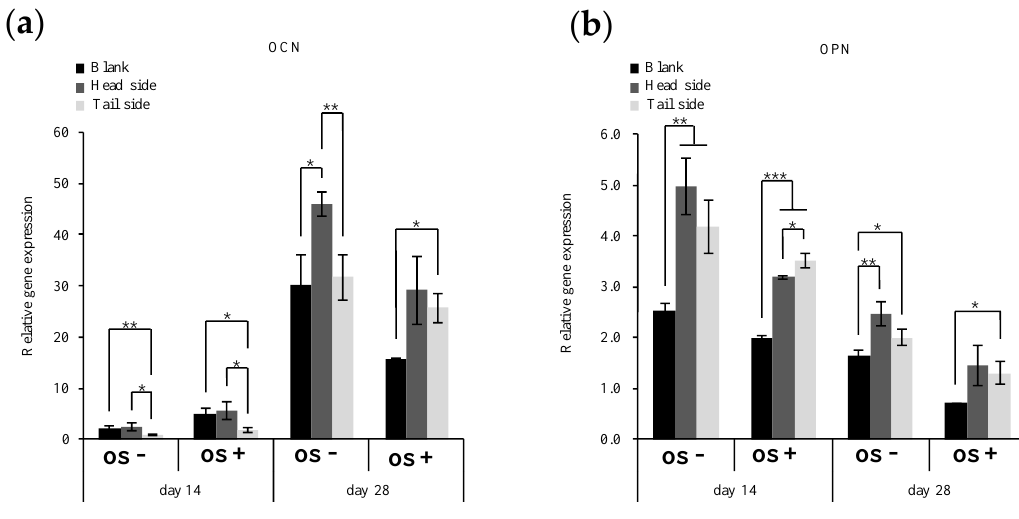
Figure 7. Relative gene expression of OCN (a) and OPN (b) on day 14 and 28. MC3T3-E1 cells on specimens were cultured in basal and osteogenic medium (OS). Real-time PCR data were calculated from independent samples ( n ≥ 3). All values are shown as the mean ± standard deviation ( n ≥ 3). All results were compared by a one-way ANOVA with Tukey’s test using SPSS Statistics 17. The results with p values < 0.05 were deemed to be significant (* p < 0.05, ** p < 0.01, *** p < 0.001); n.s., not significant ( p > 0.05).